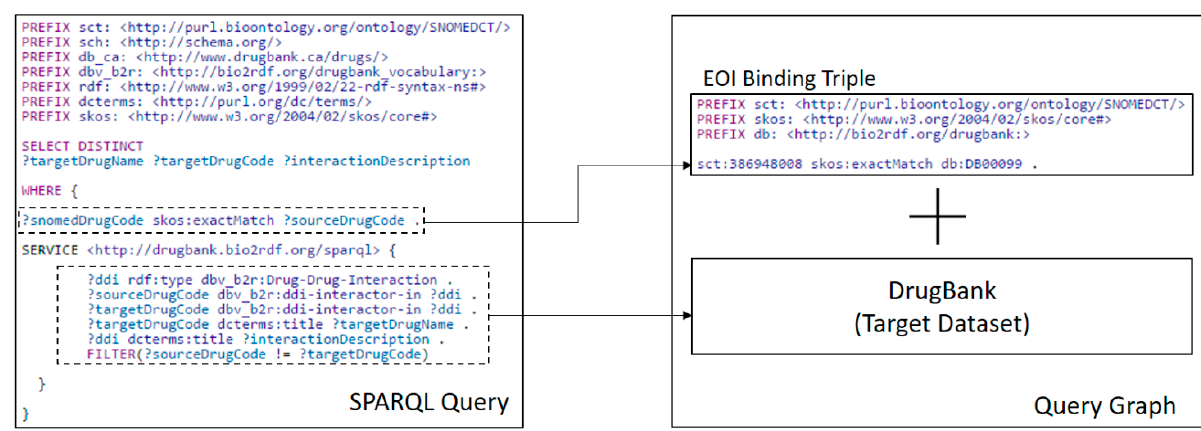
Figure 4. The SPARQL query and the query graph of the example in section C. The first part of the query in the WHERE clause ( ?snomedDrugCode skos:exactMatch ?sourceDrugCode. ) references the EOI binding triples. The second part of the query, the SERVICE clause, specifies how the EOI binding triples filter the target dataset. Finally, the SELECT clause specifies the data items from the target dataset that constitute the augmentation content ( ?targetDrugName ?targetDrugCode ?interactionDescription ).